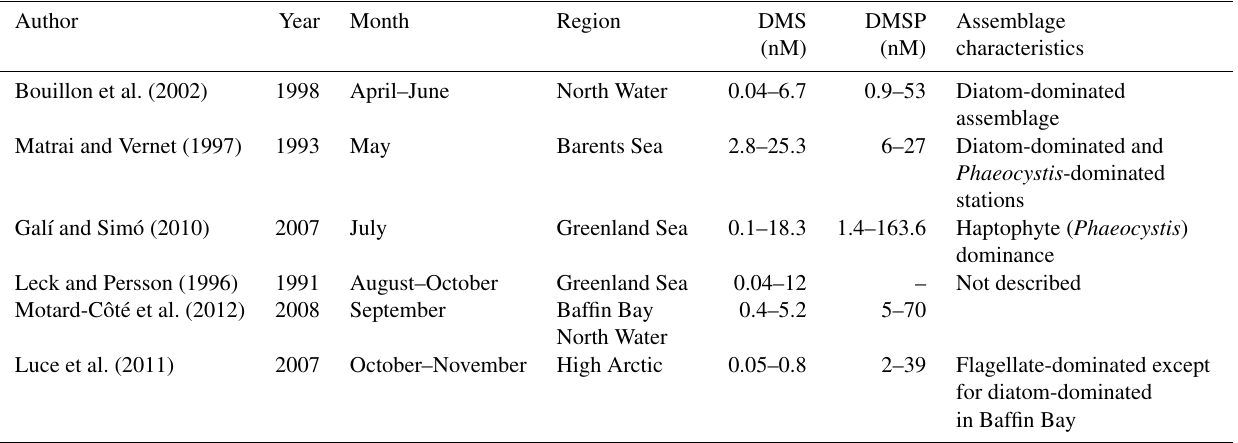
Table 5. Compilation of published Arctic and subarctic Atlantic DMS(P) data from the summer and fall months, focusing on observations from the Western